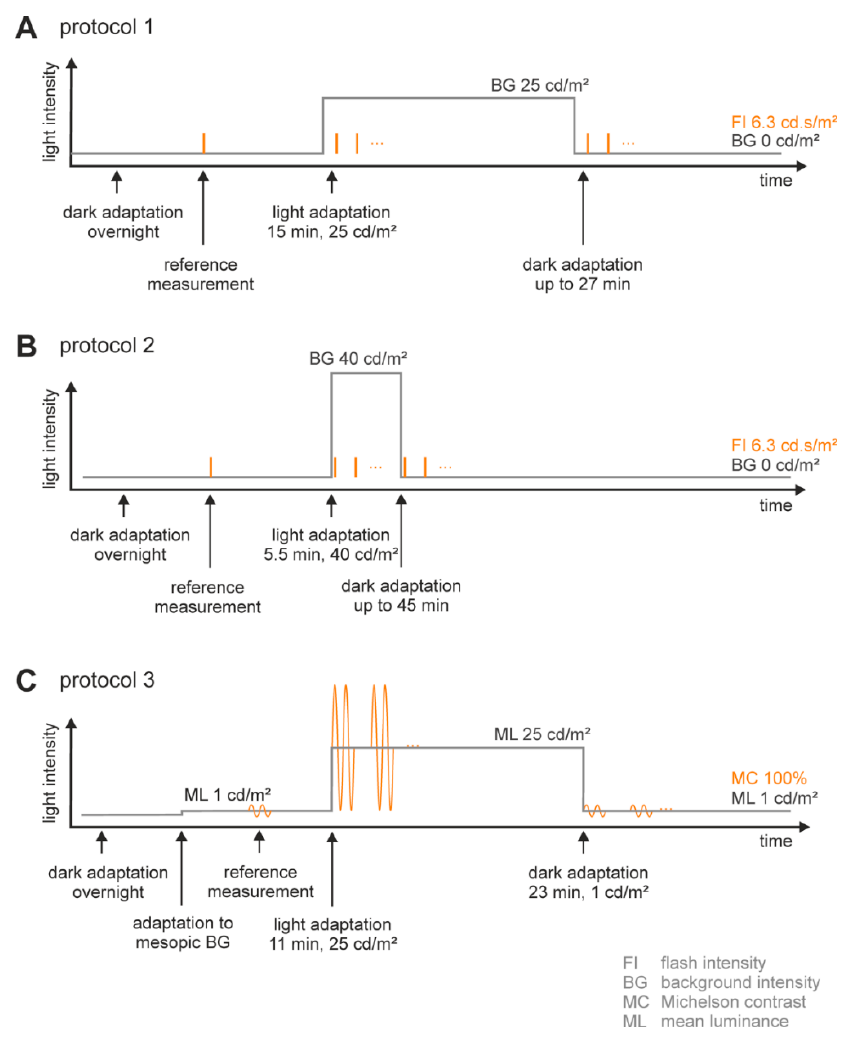
Figure 7. Schemes of the different adaptation protocols. ( A ) A baseline (reference) flash ERG. Flash ERGs were measured at dark adaptation. Subsequently, flash ERGs were measured at regular intervals during a 15 min period with 25 cd/m 2 background, followed by a maximum of 27 min of dark adaptation. In the second protocol ( B ), after the reference measurement, the animals were adapted for 5.5 min to 40 cd/m 2 followed by a maximum period of 44 min of dark adaptation; ( C ) For the flicker ERGs, the adaptation sequence was as follows: reference measurements at 1 cd/m 2 ; 11 min 25 cd/m 2 ; 23 min 1 cd/m 2 .